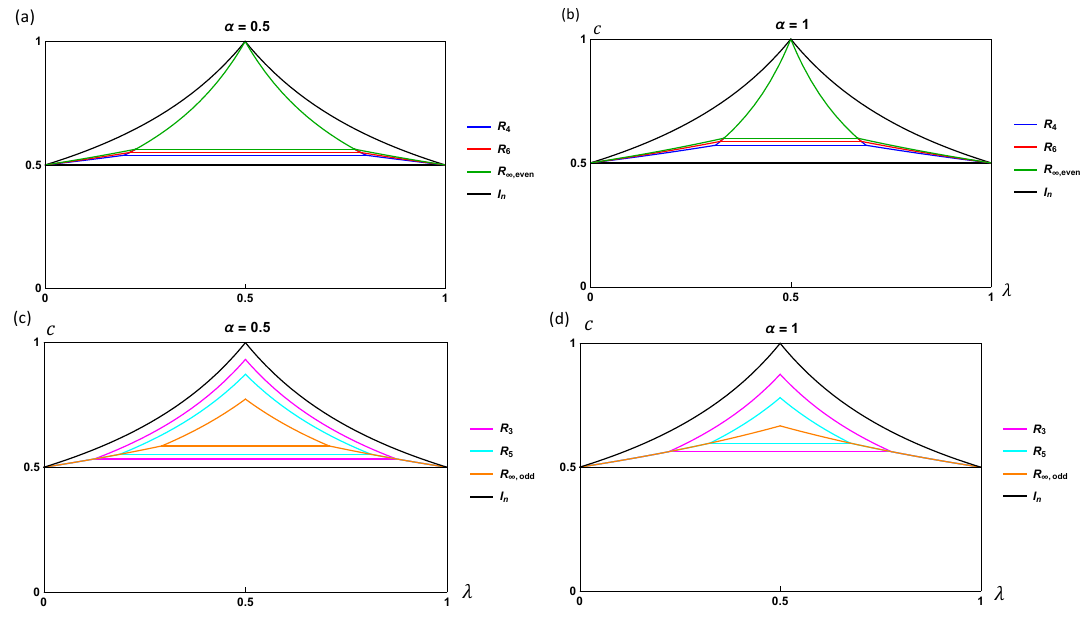
Figure 7 . Transition lines for R n at two different values of α for f ( β ) in (4.59).